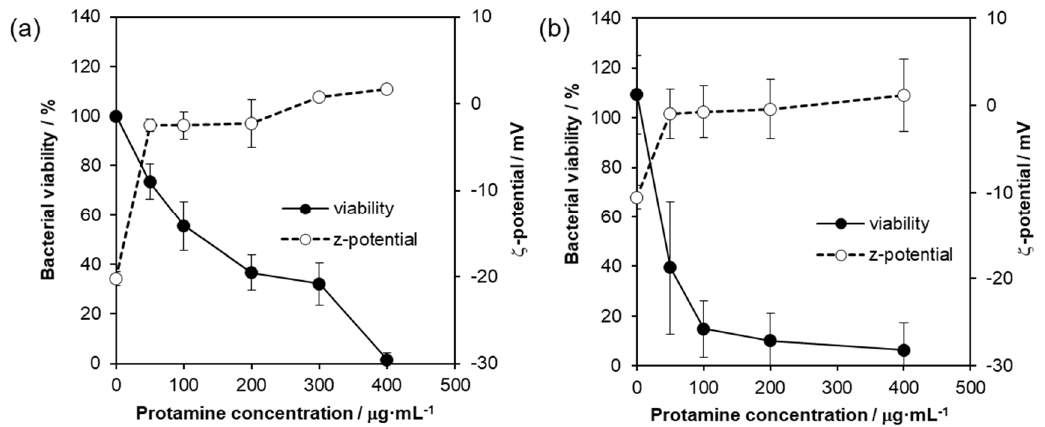
Figure 6. The bacterial viability and zeta potential of bacteria by treatment of protamine. E. coli ( a ) and S. aureus ( b ) were treated with protamine for 18 h. Various concentrations of protamine were tested. Solid circles (- ● -) indicate the % of viable bacterial cells by treatments of protamine, while the zeta potential is represented by the open circles (- ○ -). Each value represents the mean of triplicate tests. Error bars indicate the standard error of the mean.